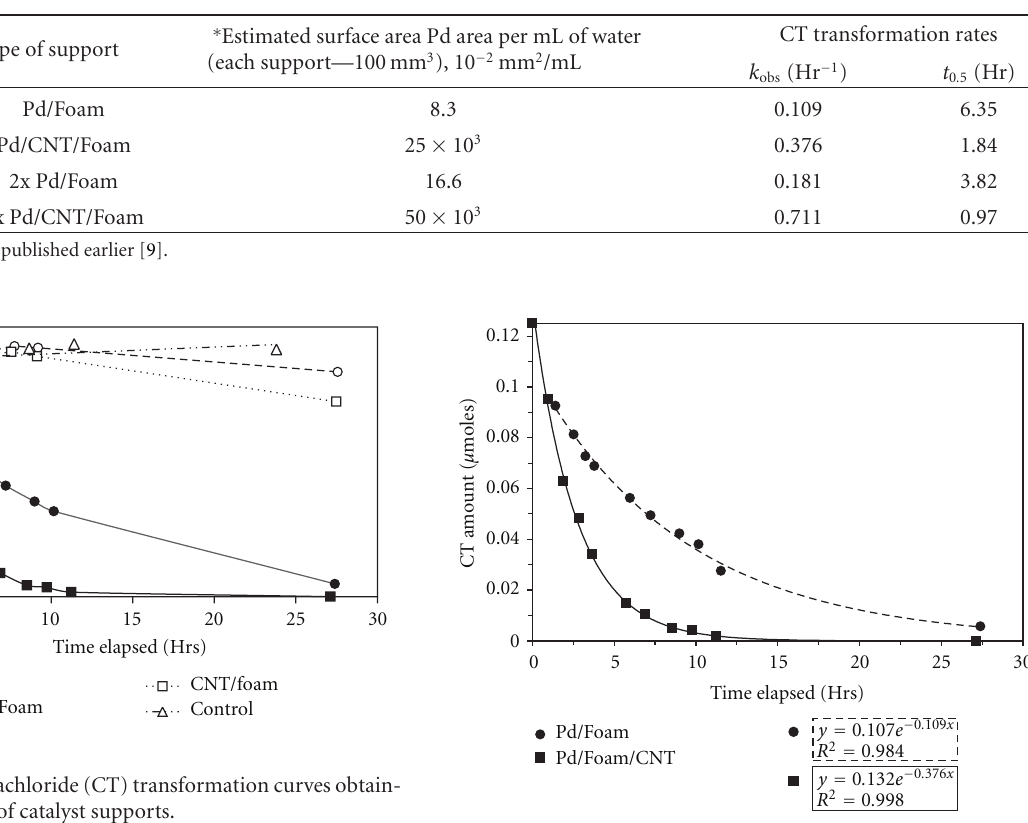
Figure 3: Carbon tetrachloride (CT) degradation curves with expo- nential curve fitting obtained for Pd/Foam and Pd/CNT/Foam